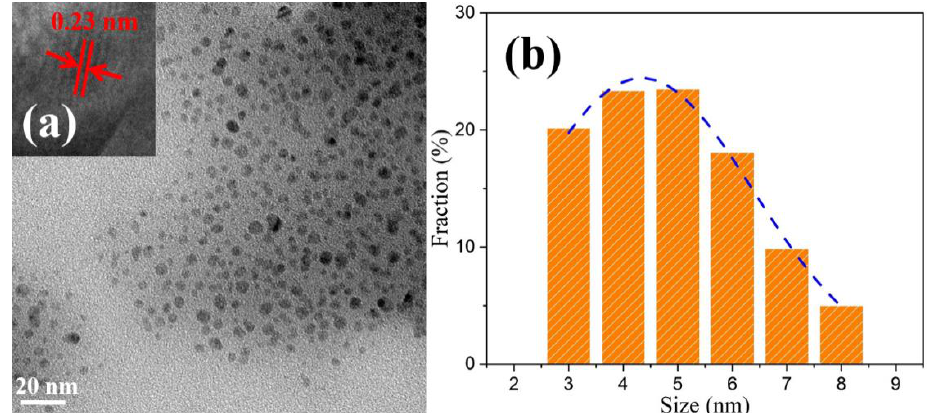
Figure 2. ( a ) Transmission electron microscope (TEM) image of synthesized MoSe 2 QDs. The inset shows representative high-resolution TEM (HRTEM) image of the MoSe 2 QD. ( b ) Statistical analysis of the size of MoSe 2 QDs measured by TEM and its Gaussian fitting